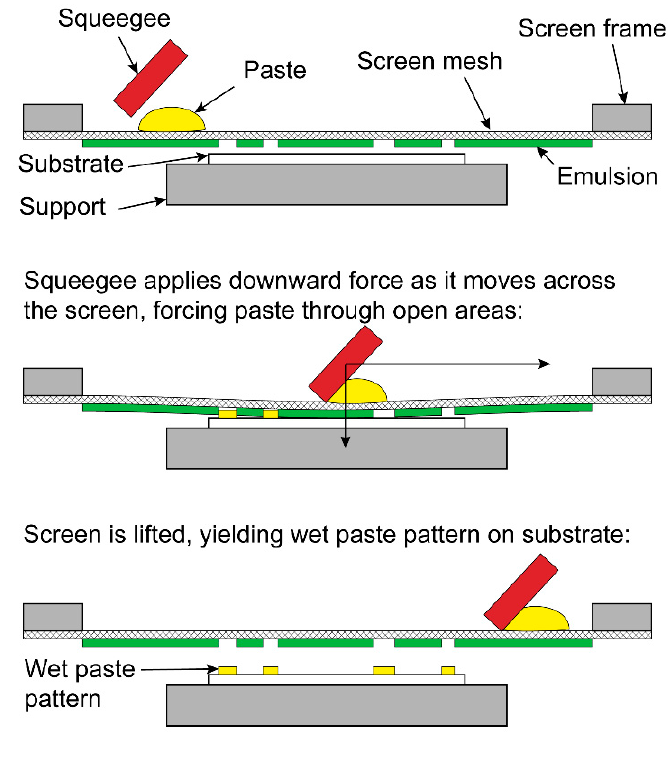
Figure 3. Thick film printing process.